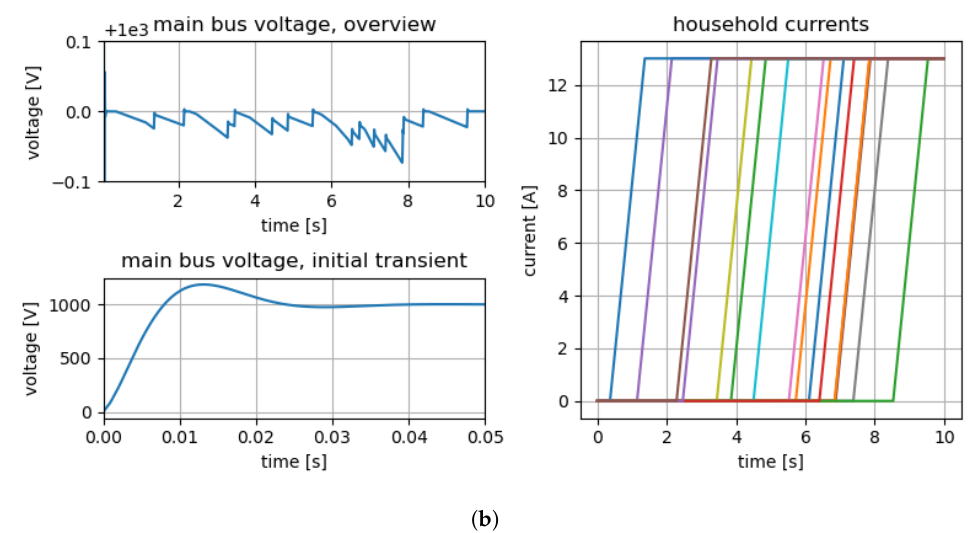
Figure 6. Simulation results of a 16-household microgrid with ramps in each household for ( a ) PinT and ( b ) sequential execution. The simulation was performed with a cold-start (all voltages and currents equal to zero). The initial transient of the main bus voltage is shown in the lower left plots, respectively. The development of the current over the whole simulation interval is shown in the respective upper left plots (note the shift of the abscissa by the target voltage, 1000V). The main bus voltage stays well within an error interval of ( 1000 0.1 ) V. The currents in the households are ± summarized in the right-hand side plots. Each household ramps up its power consumption from zero to 8.450kW over one second, with randomly chosen switch-on times. ( a ) Results of PinT simulation. Some minor artifacts resulting from iterating only until the chosen error tolerance was reached are visible. ( b ) Results of sequential simulation for